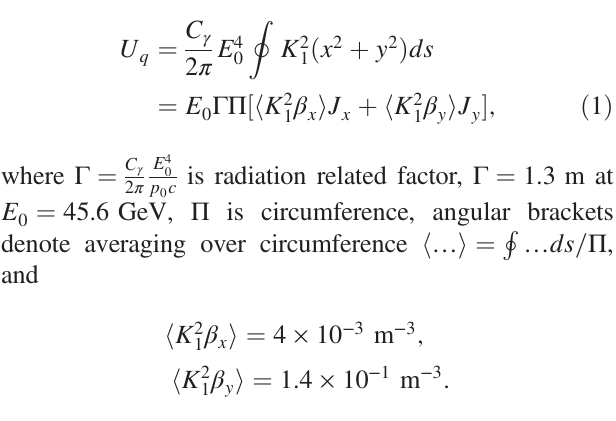
TABLE II. Total energy loss from dipoles, final focus quadru- poles QFF , focusing and defocusing arc quadrupoles QF and QD .